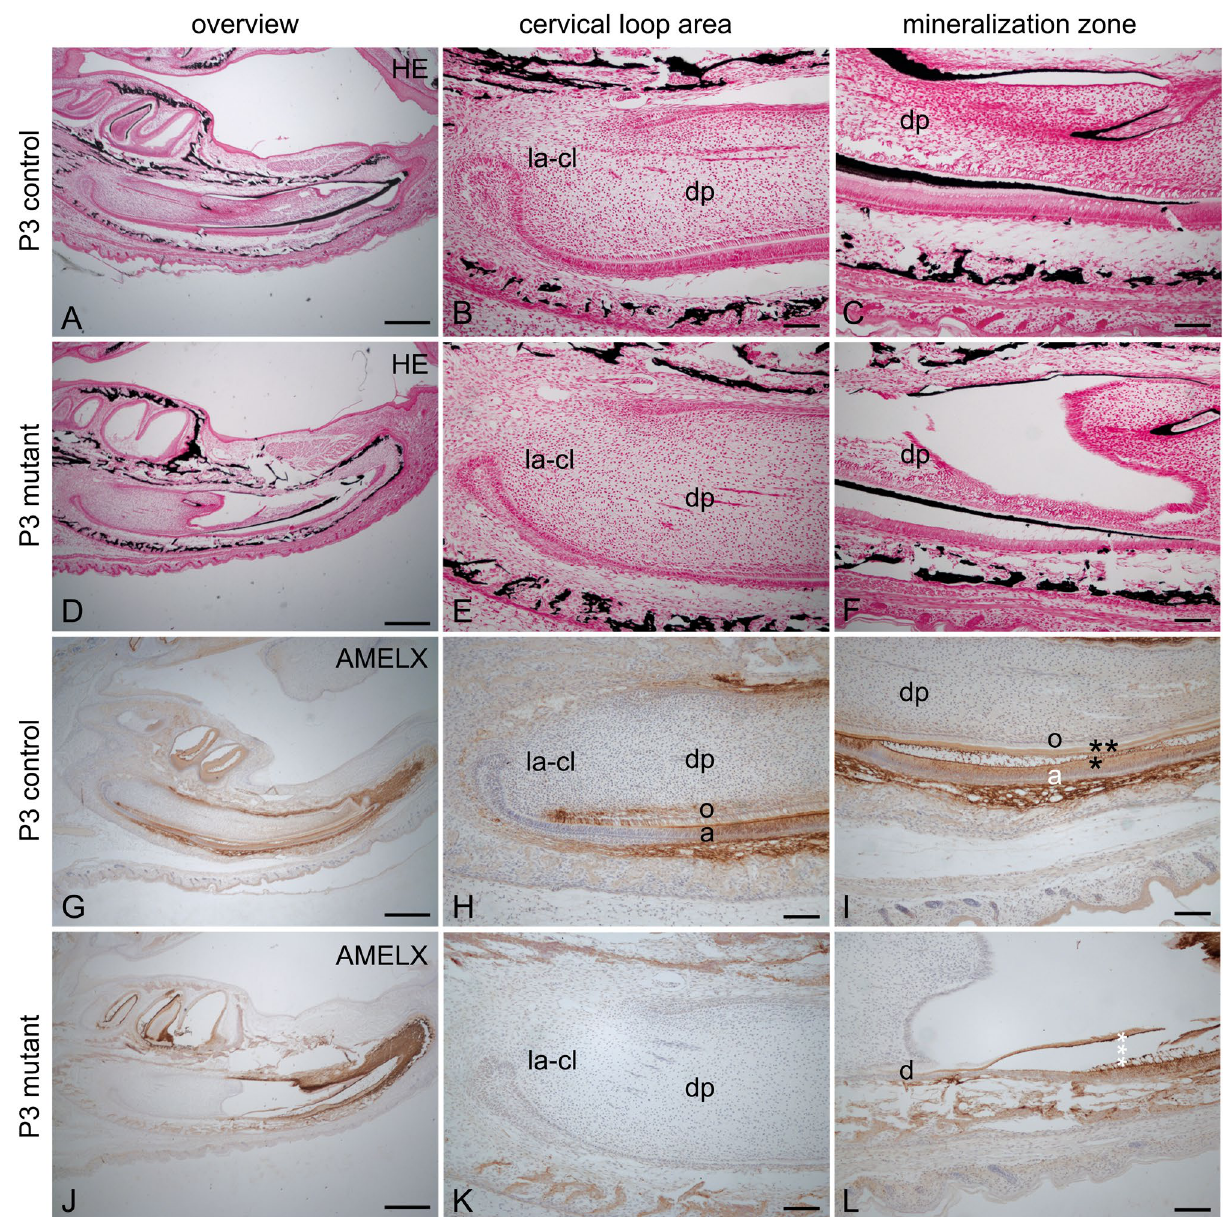
Figure 3. Von Kossa staining and localization of amelogenin and in the developing incisors of control and mutant P3 K320E-Twinkle Epi mice. In P3 control incisors ( A – C ) the thick extracellular dentin and enamel matrices are positive for von Kossa staining (black) overlying the secretory stage ameloblasts ( C ). In comparison to the control, von Kossa staining in K320E-Twinkle Epi mice ( D – F ) showed only a thin dentin matrix layer at the secretory stage ameloblast region ( F ) in developing incisor of mutant mice at P3. Amelogenin is detected with a strong staining intensity in P3 control ameloblasts and enamel matrix ( G – I ). In the apical incisor, amelogenin is additionally expressed by pre-odontoblasts ( G , I ). Furthermore, amelogenin is localized in the incisor dentin matrix ( I , two asterisks) and in enamel matrix ( I , one asterisk). In P3 K320E-Twinkle Epi mice incisors ( J – L ) no amelogenin expression is found in the apical secretory stage ameloblasts nor in the pre-odontoblasts ( K ). In comparison to the control, amelogenin is identified only and with weakly staining intensities in ameloblasts of the secretory stage ameloblasts ( L ). The three asterisks show the cracked dentin layer, which has a strong unspecific coloration due to section detachment (section margin effect) ( L ). la-cl, labial cervical loop; a, ameloblasts; d, dentin; dp, dental papilla; e, enamel matrix; o, odontoblasts. Scale bars: A , D , G , J = 500 µm, B , C , E , F , H , I , K , L = 100